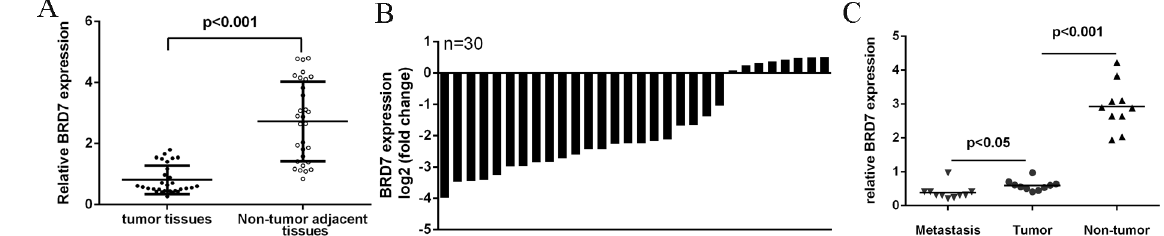
Fig 2. The expression level of BRD7 was downregulated in lung adenocarcinoma tissues. (A) Relative PBRD7 mRNA expression levels inlung adenocarcinoma tissues and their corresponding adjacent normal tissues. (B) qRT-PCR analysis of BRD7 expression in 30 pair ’ s lung adenocarcinoma tissues and their corresponding adjacent normal tissues. (C) Tissues from lymph node metastases expressed lower levels of BRD7 compared to primary lung adenocarcinoma tissues and the adjacent normal tissue.